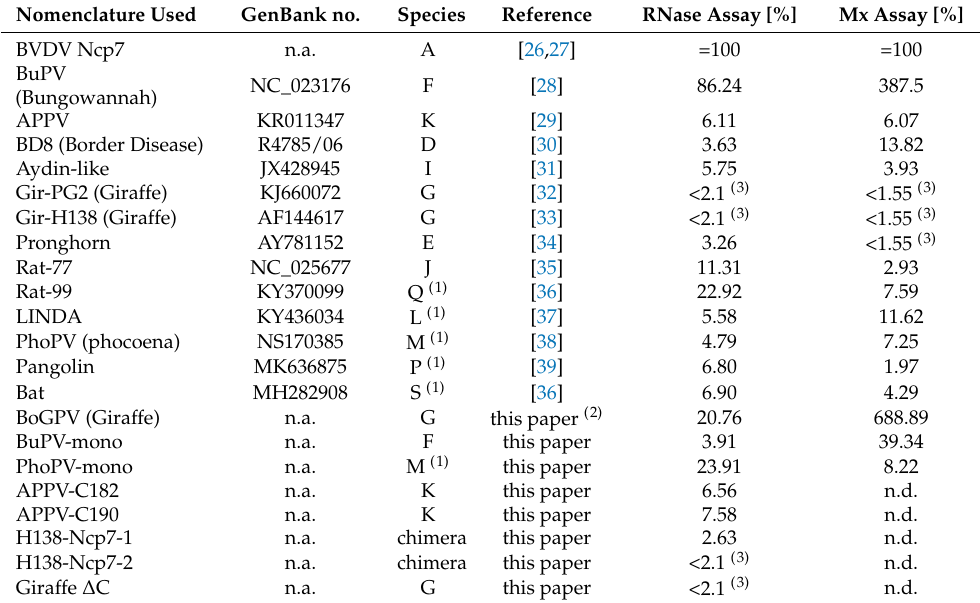
Table 1. Summary of E rns of different pestiviruses used in this study. GenBank numbers are only given for wild-type (wt) sequences, and the nomenclature of the pestivirus species was used according to [1,25]. The activities of E rns of BVDV-Ncp7 in the RNase- and Mx-assays (from Figure 3 and Figure 5, respectively) were set to